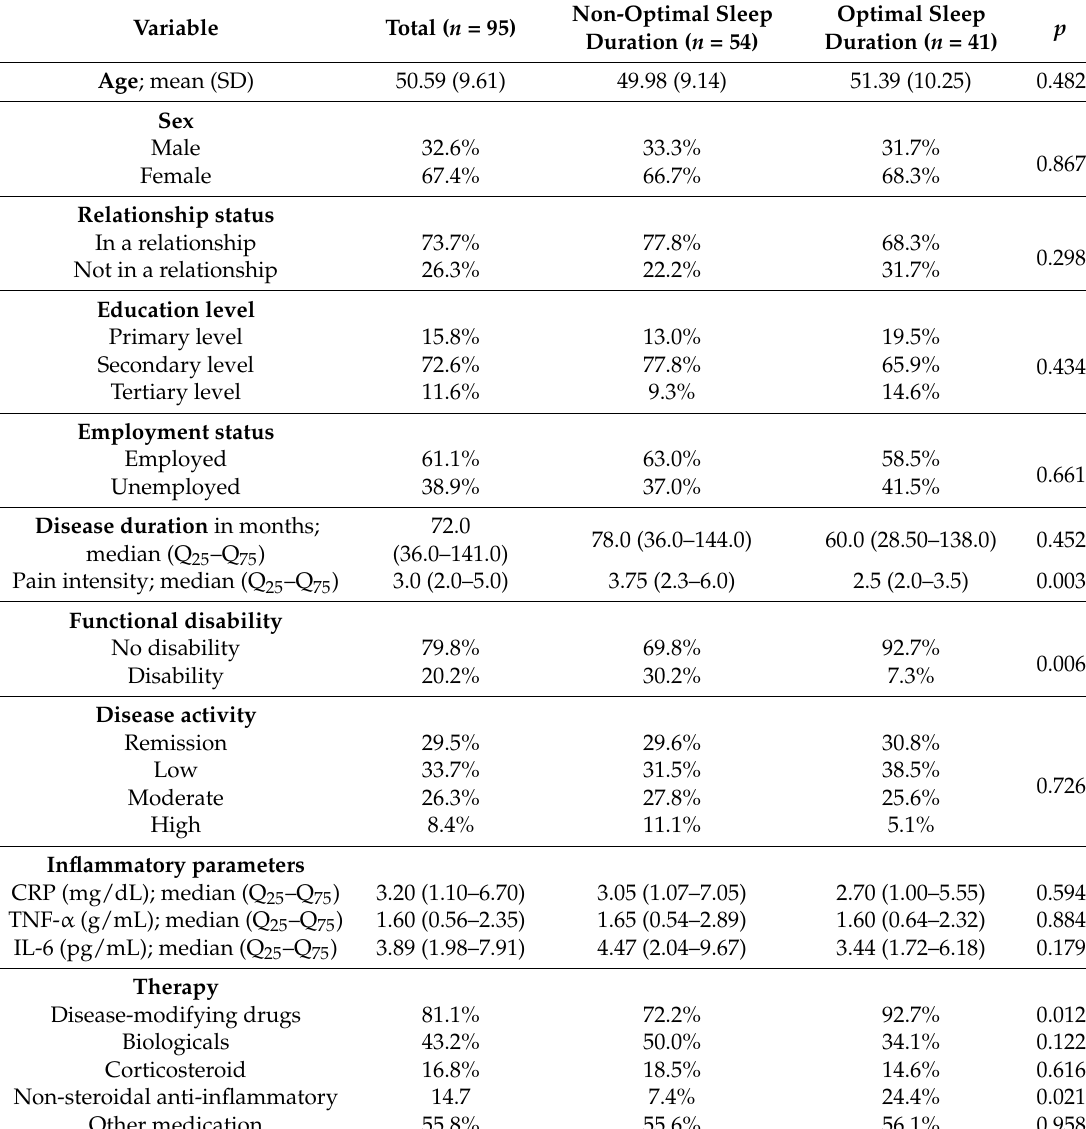
Table 1. Sociodemographic and disease-related variables stratified by optimal sleep